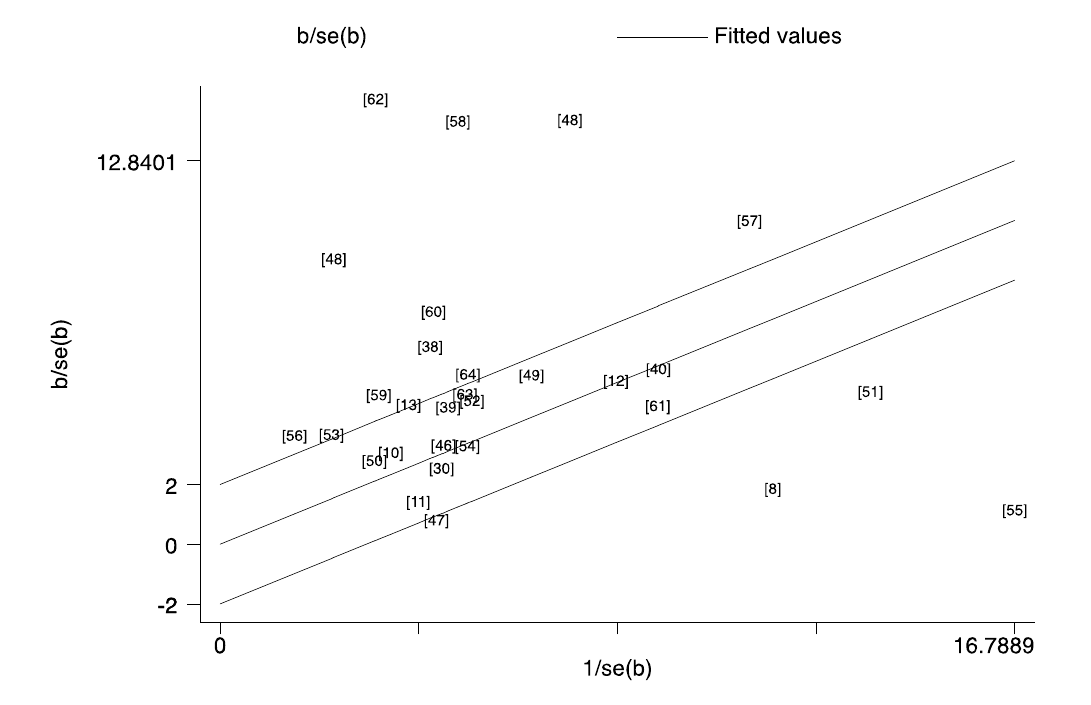
Figure 12. Galbraith plot for the contribution of results from the different studies [8,10–13,30,38–40,46–64] about mortality for ferritin to the heterogeneity. This analysis was based on the relevant data listed in Table 1 and the number orders in the plot were same to the reference list.